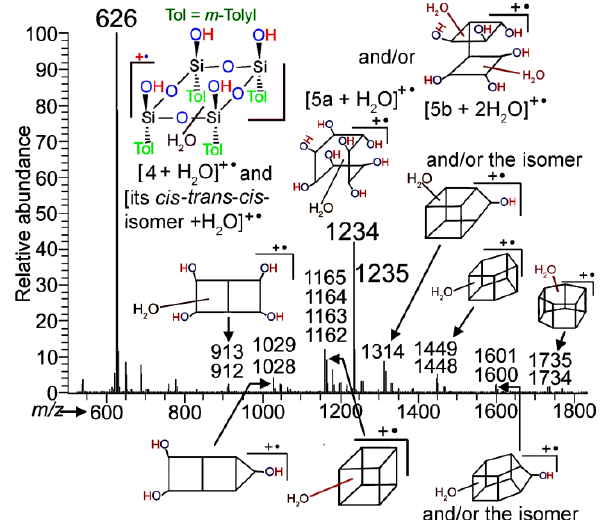
Figure 6. PI APCI mass spectrum of a mixture of products from the hydrolysis–condensation reaction of compound 1 conducted in a water-acetone solution at C HCl = 0.40 mol L −1 for 48 h.